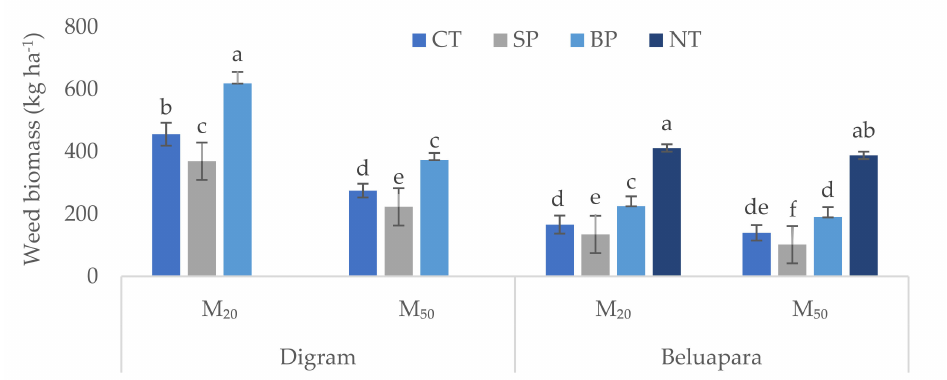
Figure 1. Effect of tillage practices and residue levels on the net weed dry biomass (kg ha -1 ) at 30 days after emergence from soil collected from Digram after 5 years and Beluapara after 3 years. Values are means of four replicates. The means for each site with similar letters (a − f) do not differ significantly at p ≤ 0.05. CT = conventional tillage, SP = strip planting, BP = bed planting, NT = no tillage, M 20 = 20% residue, M 50 = 50% residue. Whiskers mean the standard deviation.